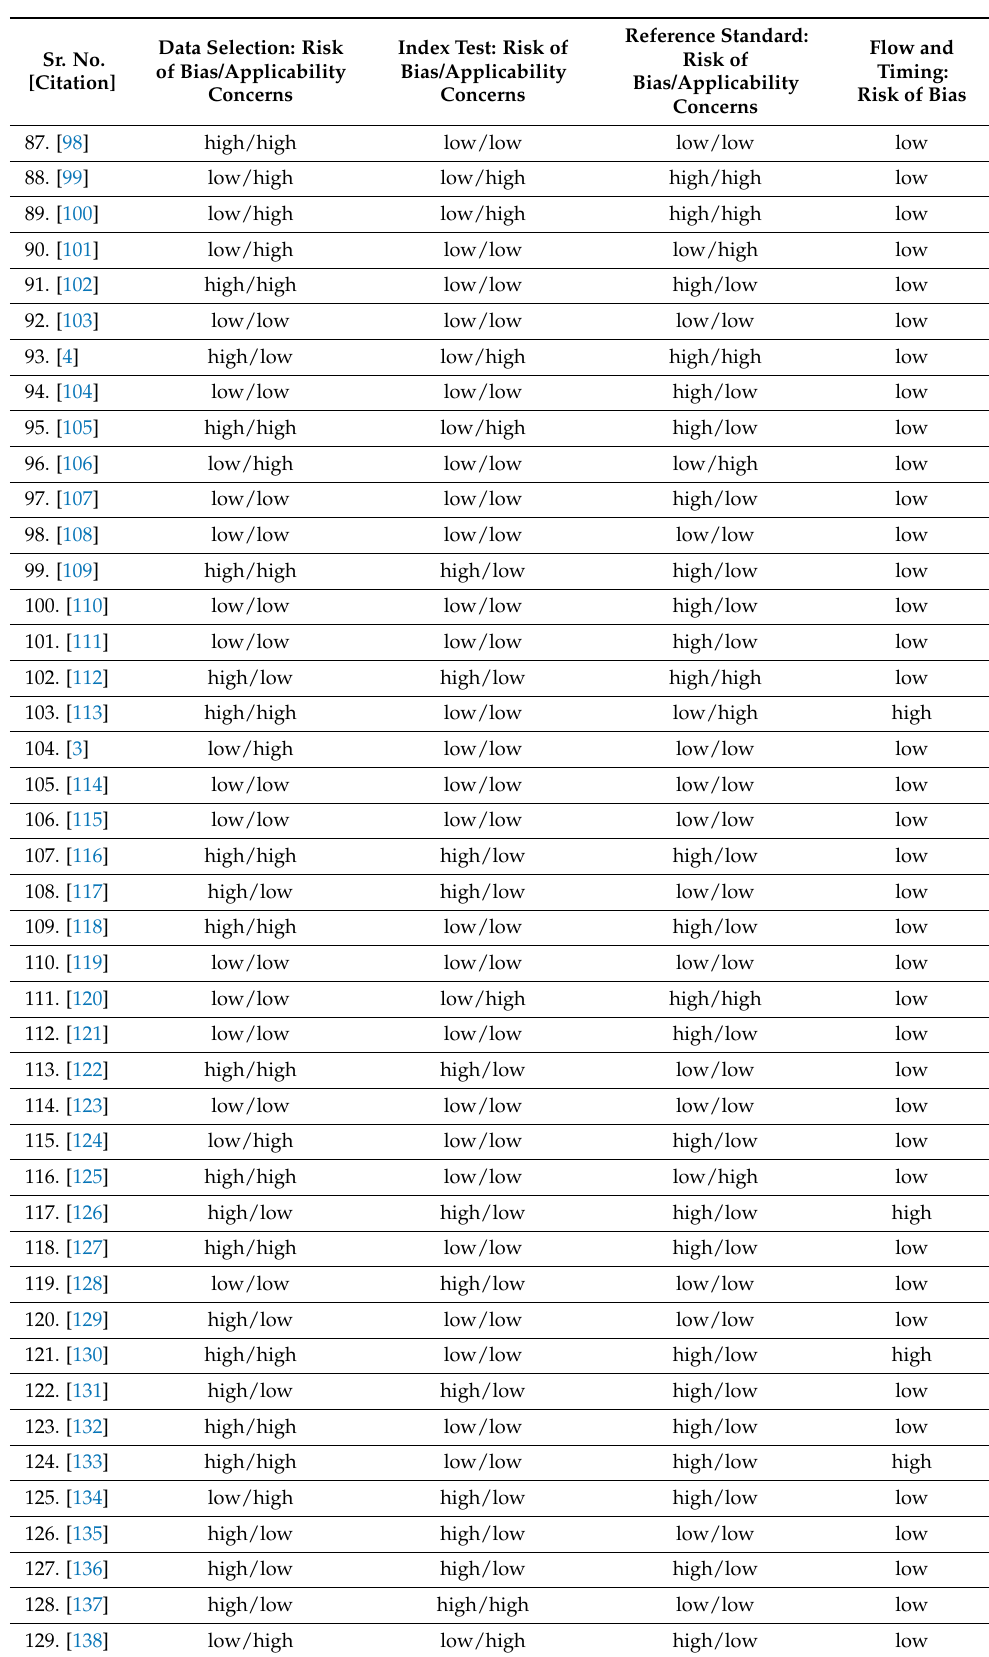
Table 1. Cont. Sr. No.